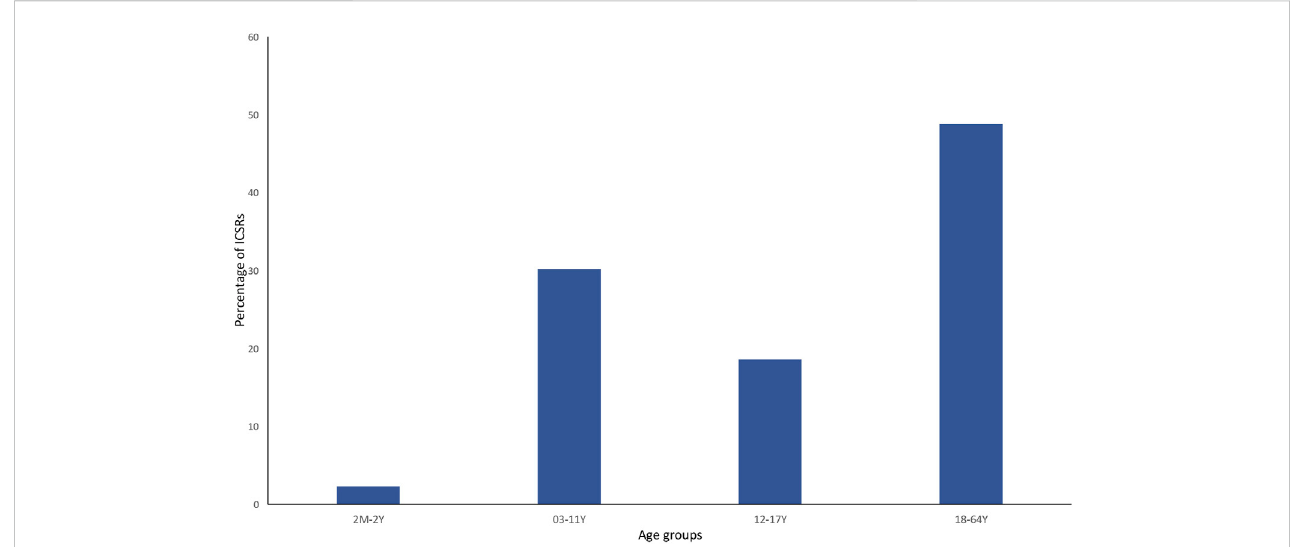
FIGURE 1 Percentage of serious individual case safety reports (ICSRs) (N = 44) in the EudraVigilance database related to cannabidiol use as an antiepileptic medication in the years 2019 – 2022, distributed according to age. 2 M – 2 Y = 2 months – 2 years; 03 – 11 Y = 3 years – 11 years; 12 – 17 Y = 12 – 17 years;